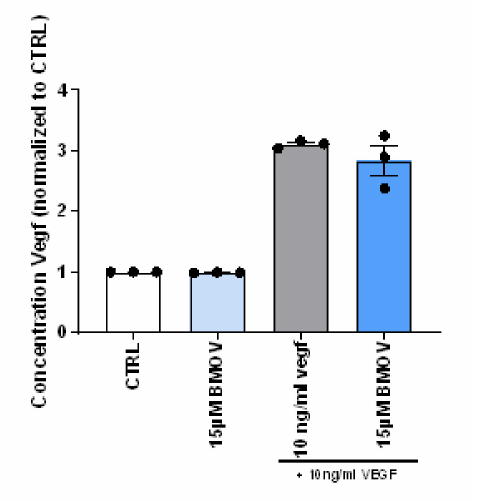
Figure 3. Quantification of the concentration of VEGF-A concentration in the cell culture medium of HUVECs incubated with the indicated conditions. All data points represent normalized averages obtained from 3 independent experiments and are presented as mean ± SEM. Two-sided Student’s t test to compare control versus BMOV